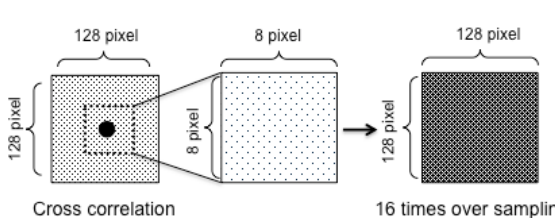
Figure 5. Example of the cross-correlation field and 16 times over-sampling